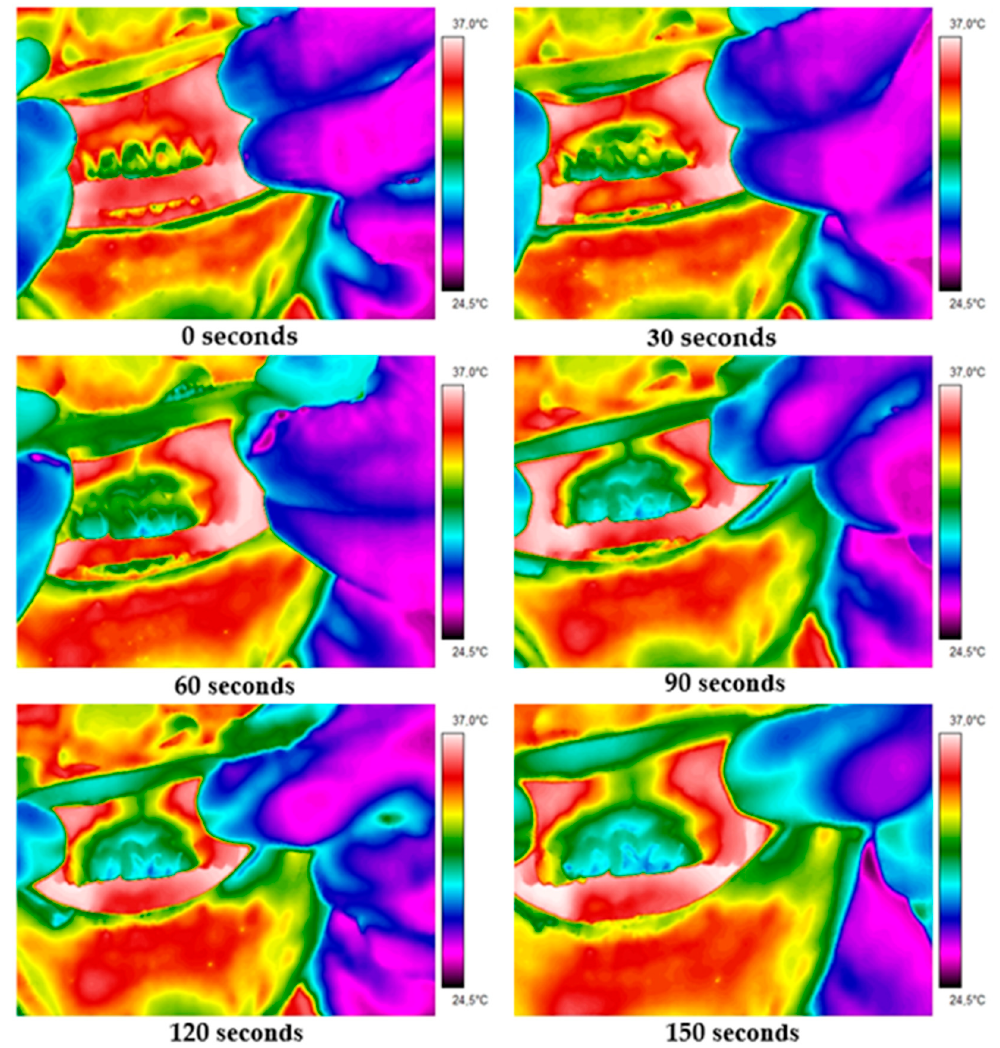
Figure 2. Thermal images of patient II obtained just after opening the mouth and at 30, 60, 90, 120 and 150 s after. There are two teeth imaged—tooth 22 after resection and contralateral healthy tooth 12. The mean differences between the average temperatures derived from the thermal images in the periapical regions of the suspect and contralateral teeth are presented in Figure 3.